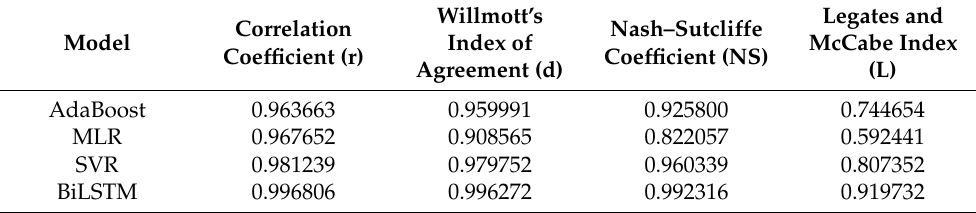
Table 7. Model performance metrics for